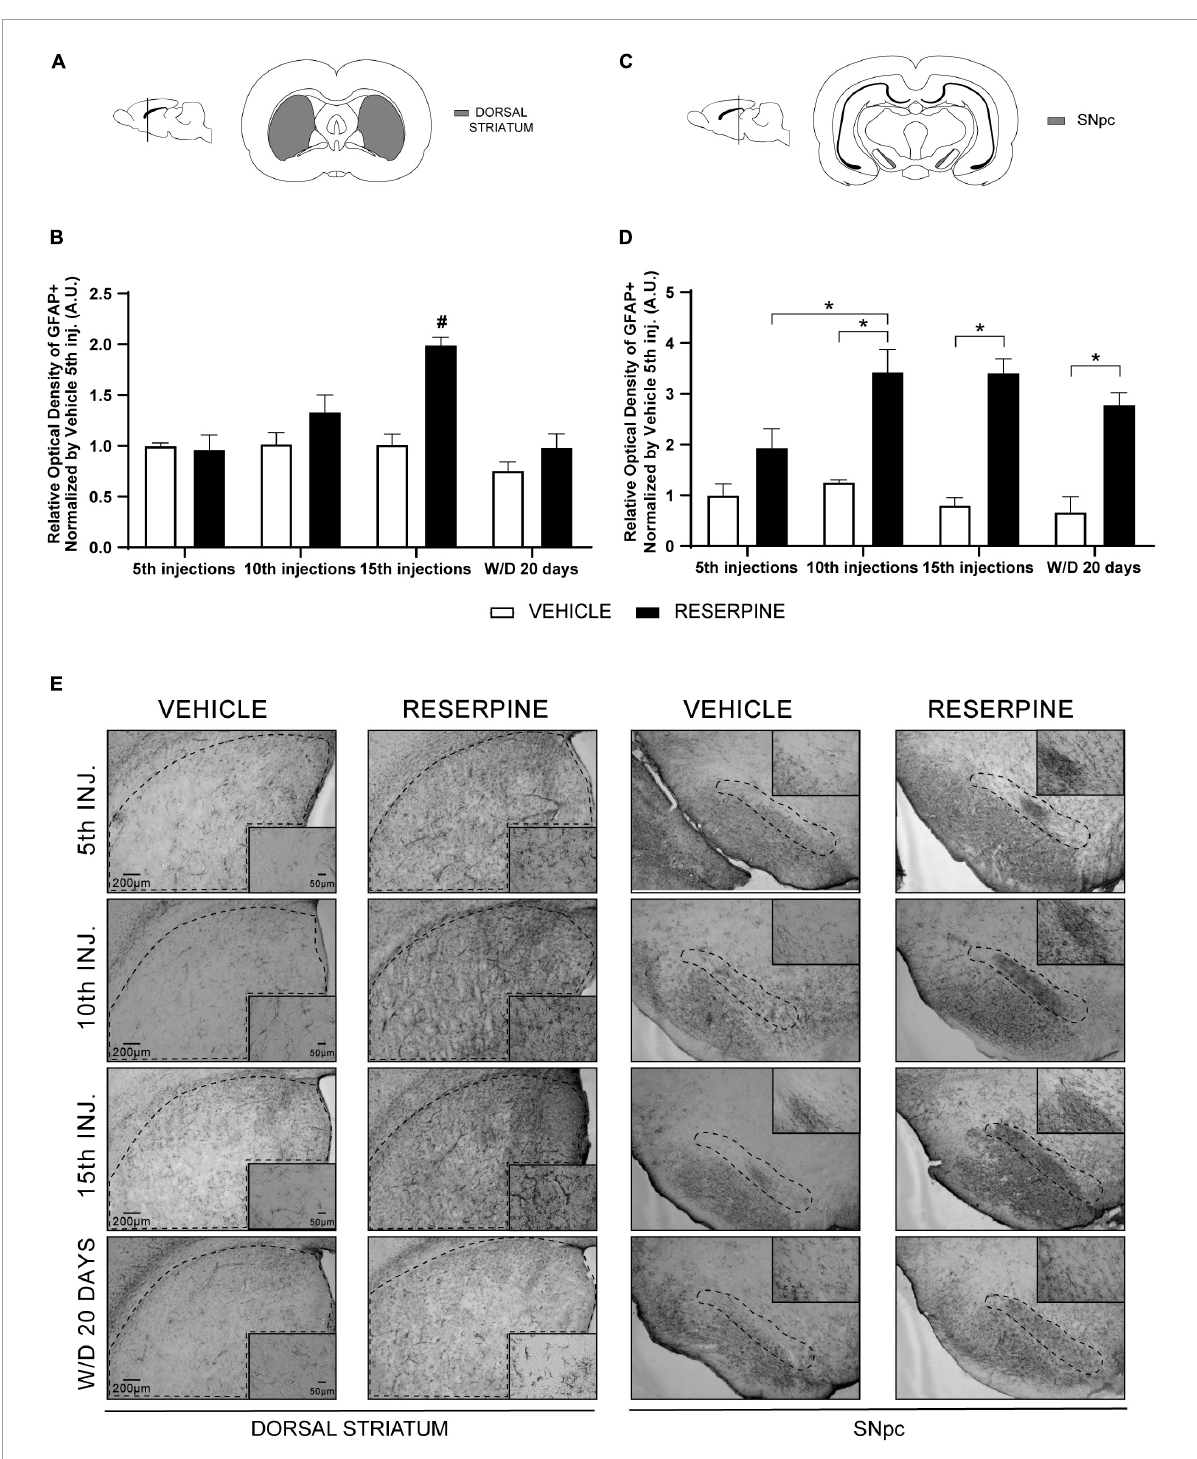
FIGURE4 Coronal slice scheme of Dorsal Striatum (A) and SNpc (C) ; effects of repeated administration of 0.1 mg/kg reserpine ( n = 5) on relative optical density (ROI) of GFAP staining in Dorsal Striatum (B) and SNpc (D) ; and representative photomicrographs of GFAP immunostaining in coronal sections (E) . Data are shown as mean + SEM. # p < 0.05 comparing Res15 with all Reserpine and Vehicle groups; * p < 0.05 comparing Reserpine and Vehicle groups (ANOVA followed by Sidak’s test). Scale bar 200 µ m and magnification 4x in overview images and scale bar of 50 µ m further magnified insets